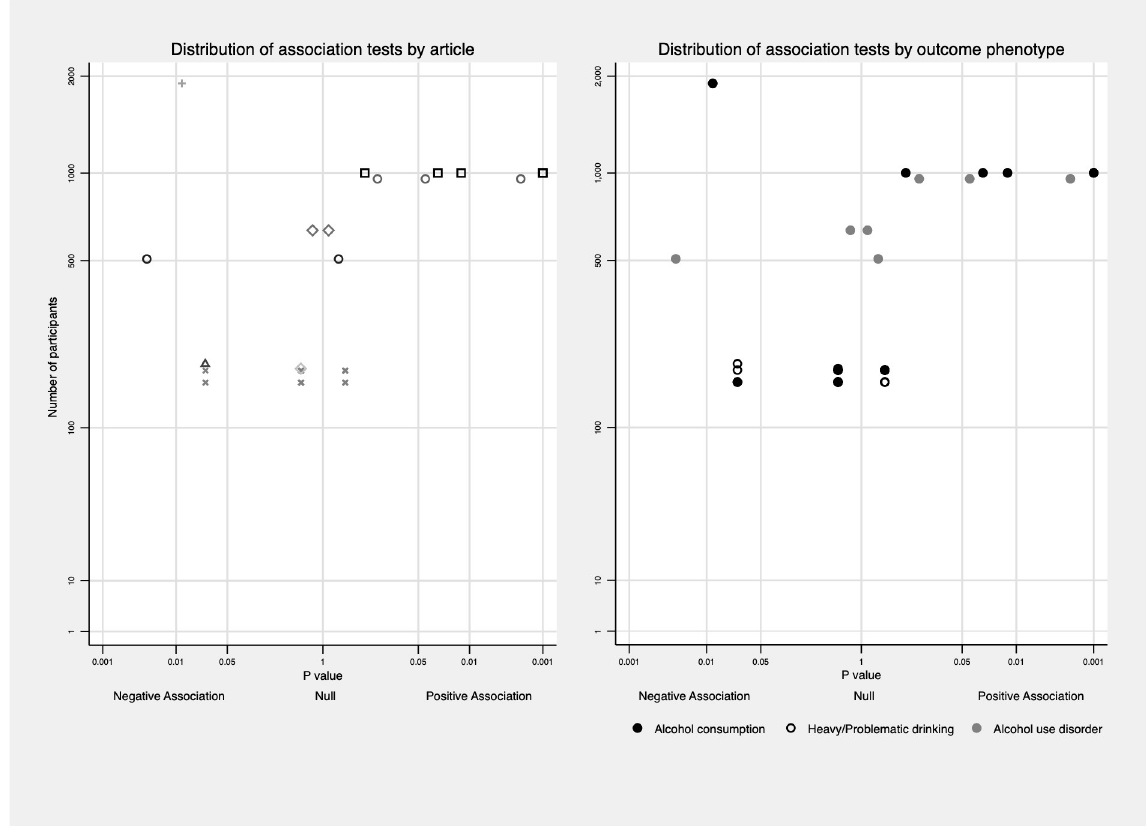
Fig 6. Distribution of association tests between anxiety and subtypes of alcohol use behaviours. Distribution of association tests clustering in one article was plotted on the left to show the non-independence among tests.